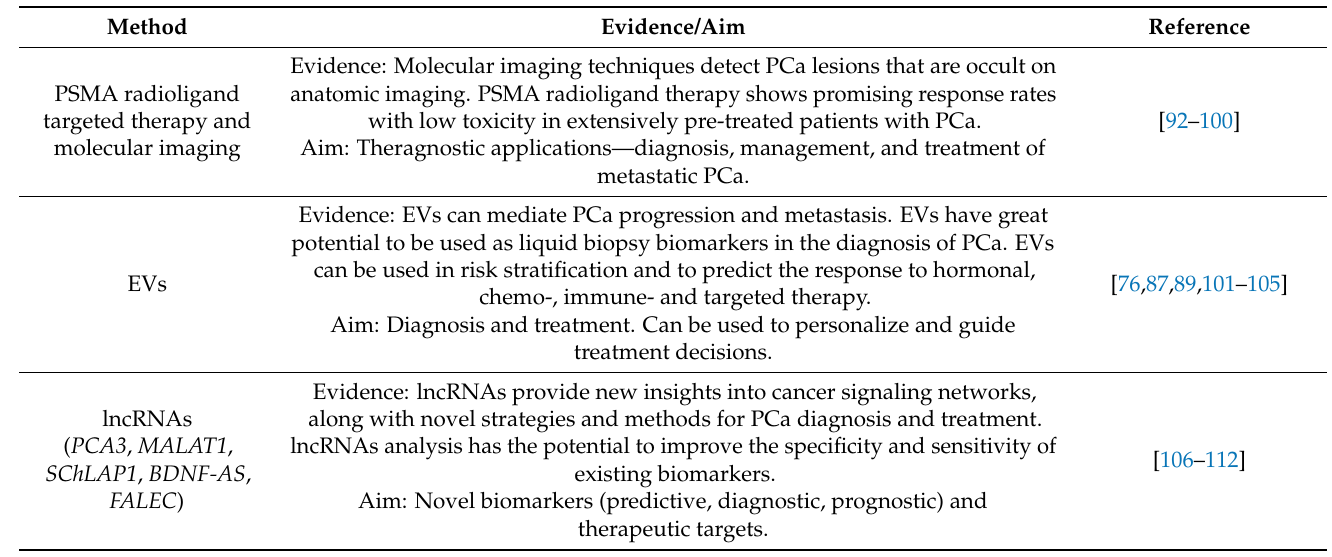
Table 2. Emerging diagnostic methods for prostate cancer detection and management (articles from the last 5